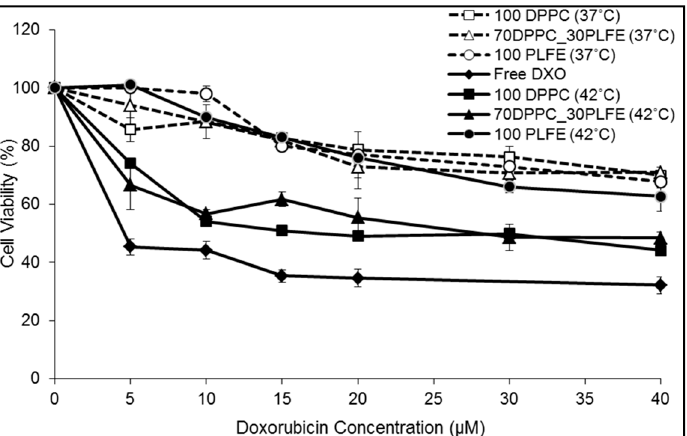
Figure 8. DXO dose dependent cell viability test. MCF-7 cells were treated with various concentrations of liposomal DXO or free DXO. Immediately after treatment, cells were either incubated at 37 ° C (control) or 42 ° C for 15 min, followed by 24 h incubation at 37 ° C. Error bars indicate the standard deviations of three samples.